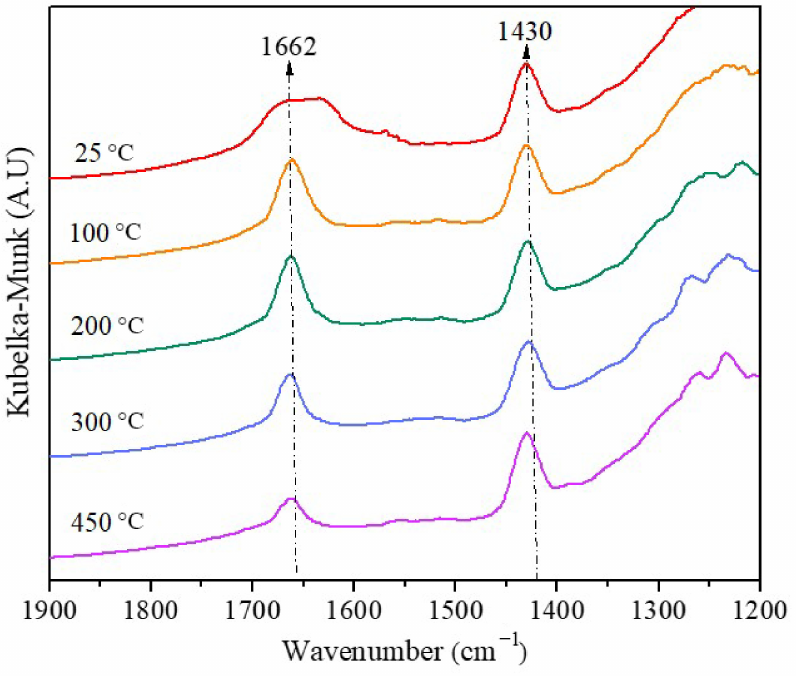
Figure 6. DRIFT spectra of NH 3 adsorbed on